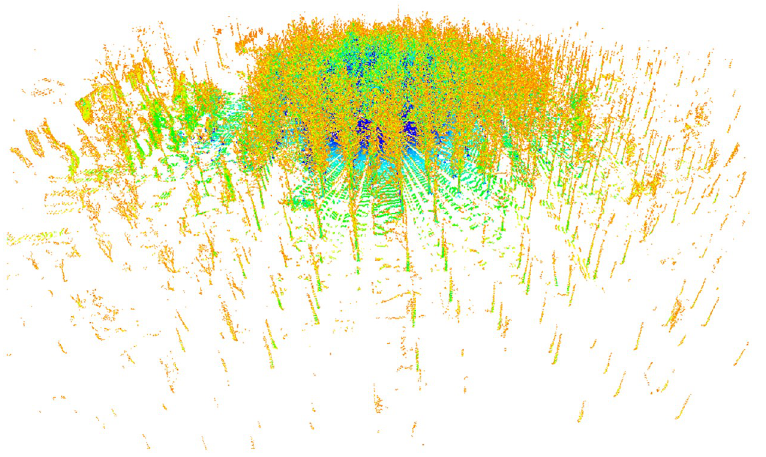
Fig 6. Point cloud data of a single scan acquired by using the BEE